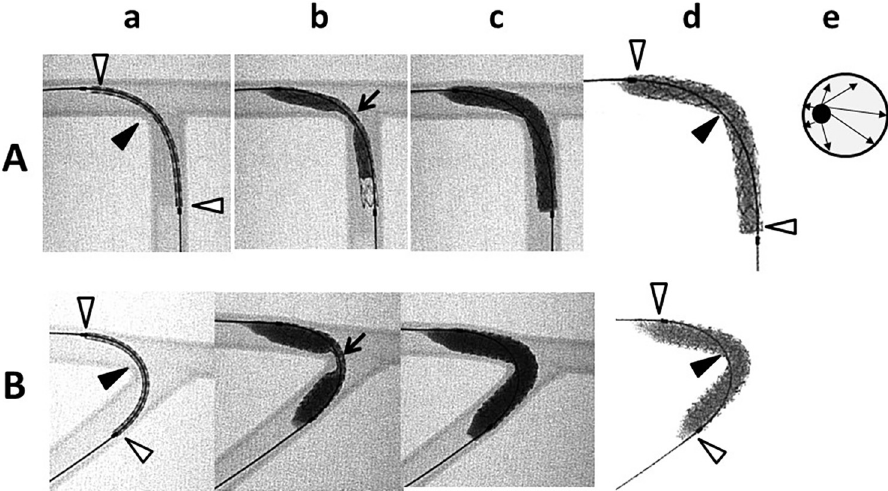
Fig 5. Experiment of the SB stenting from the MV. (A) Right-angled bifurcation. (B) Steeply angulated bifurcation at 45˚ angle between the proximal MV and the SB. (a) Initial position of the guide wire is on the inner side at the middle portion (black triangle) and towards the outer sides at both ends of the stents (white triangles). (b) In the initial phase of the inflation, the middle portion was dilated at the end (arrow). The stent was thus dumbbell shaped. (c) There was unstented area at the distal carina even after full expansion of the stents. (d) The guide wire position had not been changed during the stent expansion. Note the biased position of the wire which was in the central core in the balloon. (e) Scheme of cross section of the stent balloon inflation with the deviated position of the guide wire (black circle) at the SB ostium. Adapted from Fig 17 of reference no. 7.